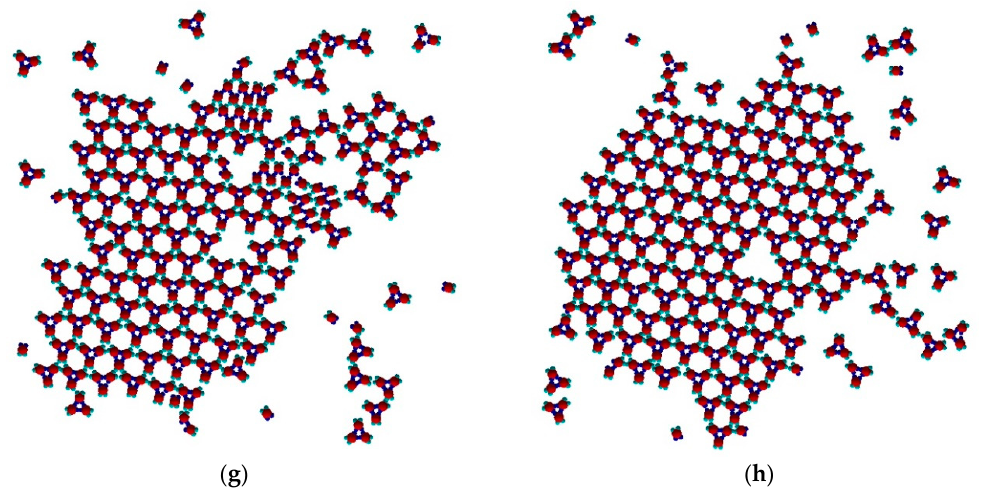
Figure 5. Snapshots from the Monte Carlo (MC) simulation at T* = 0.1 (( a ) 1 × 10 3 MCS; ( b ) 2 × 10 3 MCS; ( c ) 5 × 10 3 MCS; ( d ) 1 × 10 4 MCS; ( e ) 5 × 10 5 MCS; ( f ) 1 × 10 6 MCS; ( g ) 3×10 6 MCS; (h) 6 × 10 6 MCS).